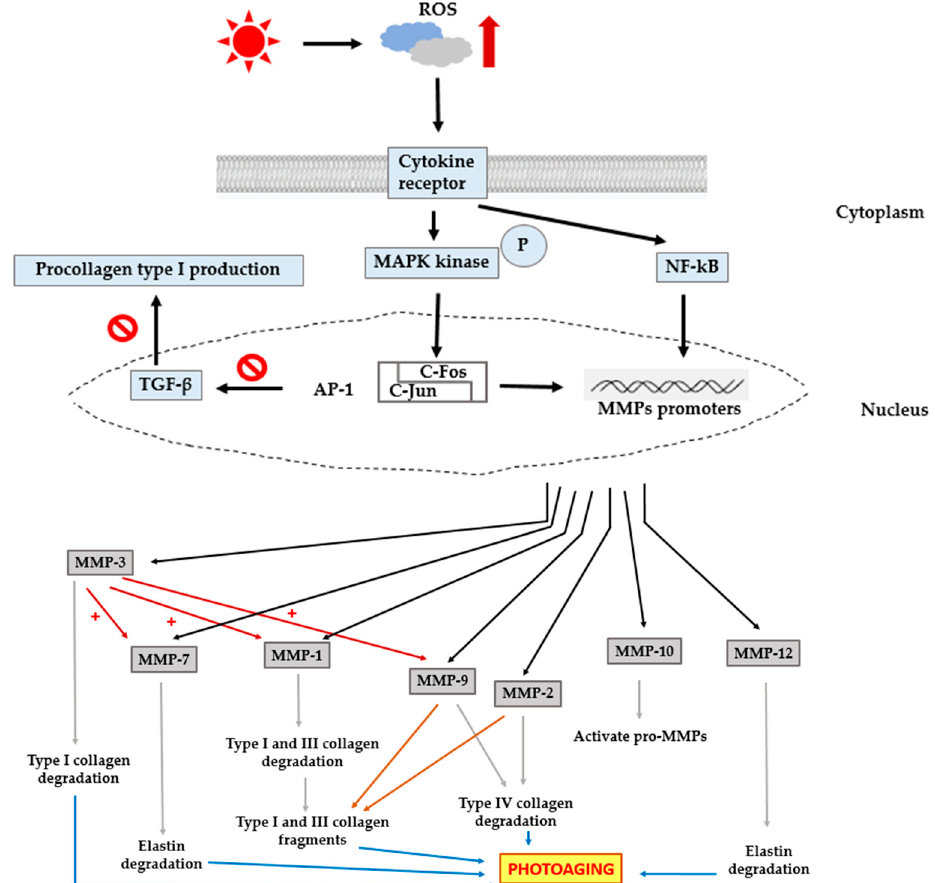
Figure 1. Schematic diagram showing the role of MMPs in photoaging. UV-induced excess intracellular reactive oxygen species (ROS) activates mitogen-activated protein kinases (MAPKs) and nuclear factor-kappa B (NF- κ B), culminating in the transcriptional regulation of MMPs, and results in the degradation of collagen and elastin, subsequently leading to photoaging. In addition to collagen and elastin degradation, AP-1 inhibits transforming growth factor beta (TGF- β ) signaling, causing a reduction in procollagen synthesis.